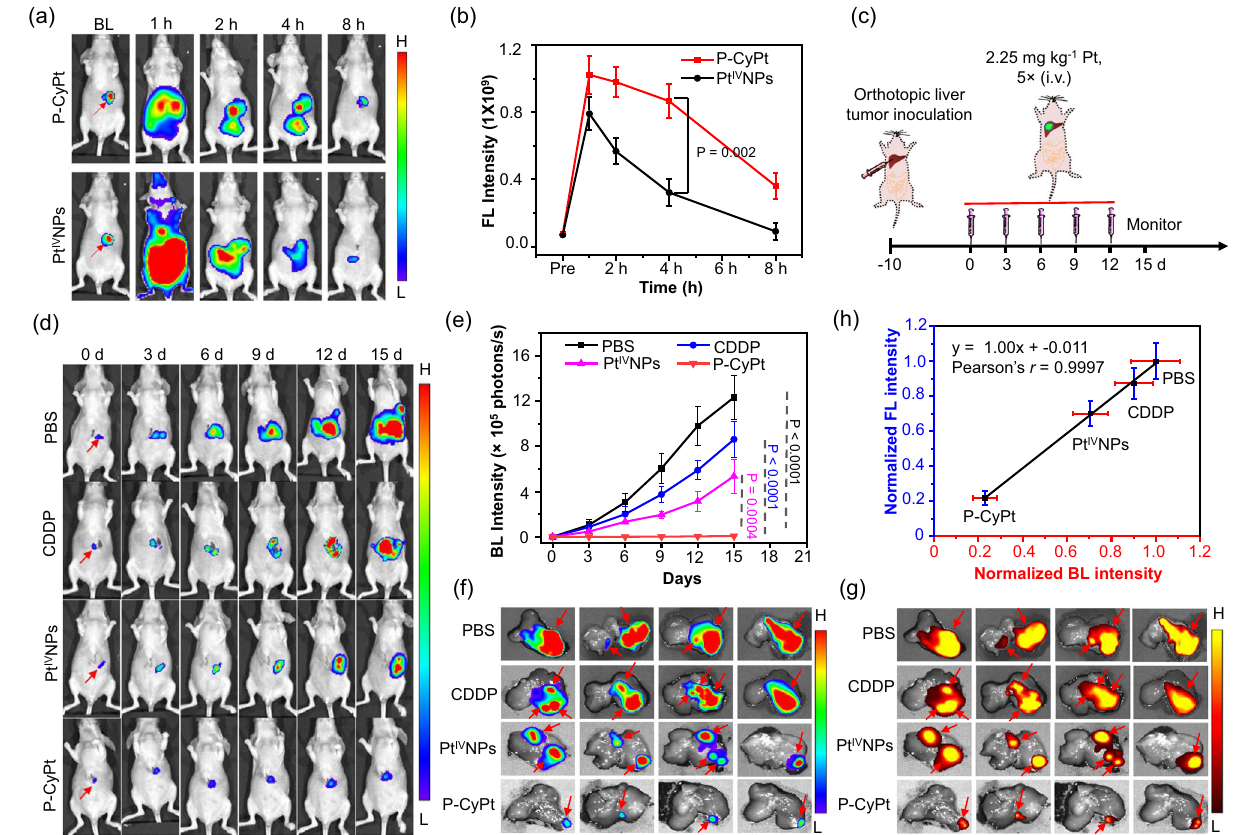
Fig. 5 | NIRFL imagingand treatmentoforthotopic HepG2/Luc livertumorsin mice with P-CyPt. a Representative bioluminescence (BL) and FL images, and b quanti fi ed FL intensity of luciferase-transfected HepG2(HepG2/Luc) liver tumors inlivingmicereceivingi.v.injectionofP-CyPtorPt IV NPs(100 μ M,200 μ L)at0,1,2, 4, and 8h. c Schematic illustration of the procedure to perform chemotherapy of orthotopic HepG2/Luc liver tumors in mice. d Representative BL images and e BL intensityofliverat0,3,6,9,12,and15dfollowingindicatedtreatments. f ExvivoBL